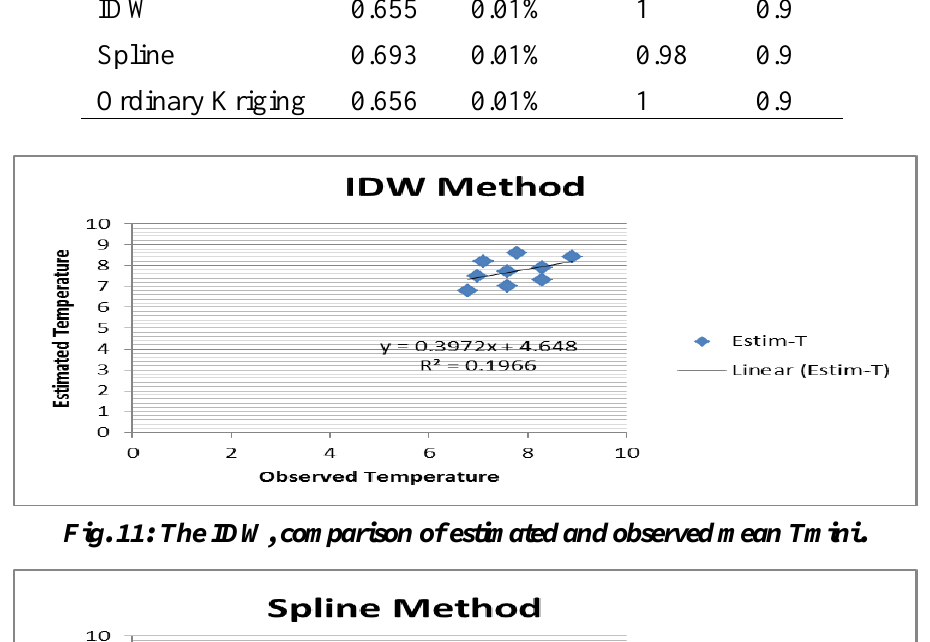
Fig. 11: The IDW, comparison of estimated and observed mean Tmini.